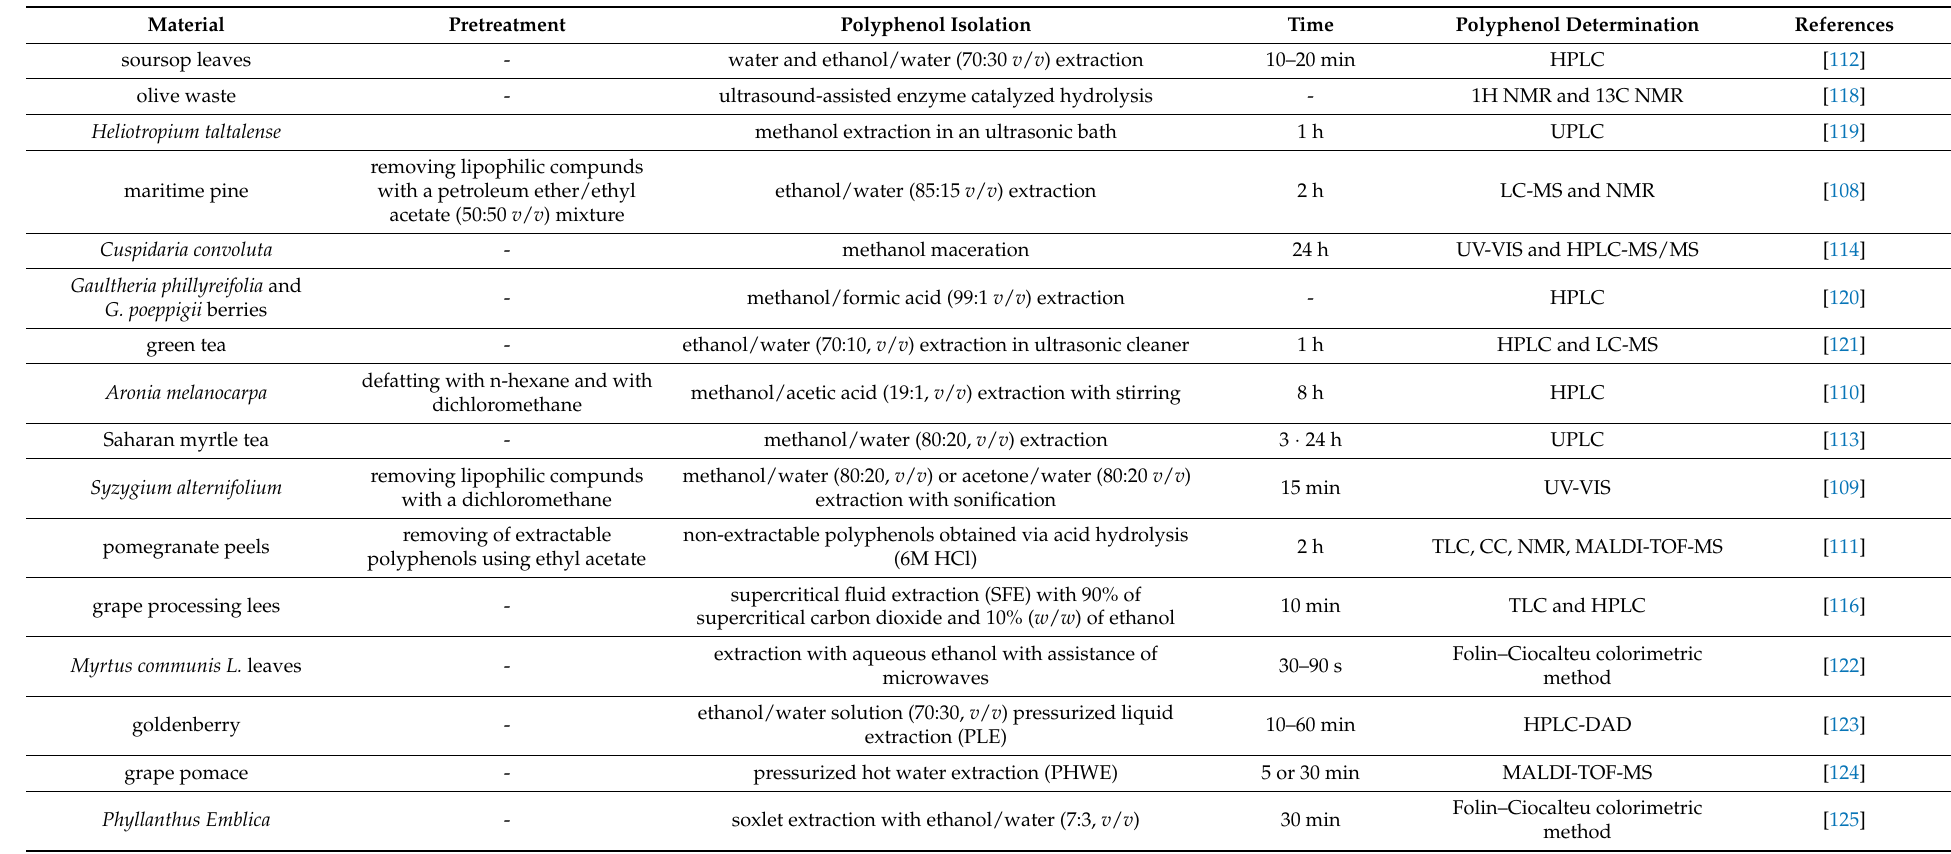
Table 3. Methods of polyphenol isolation and